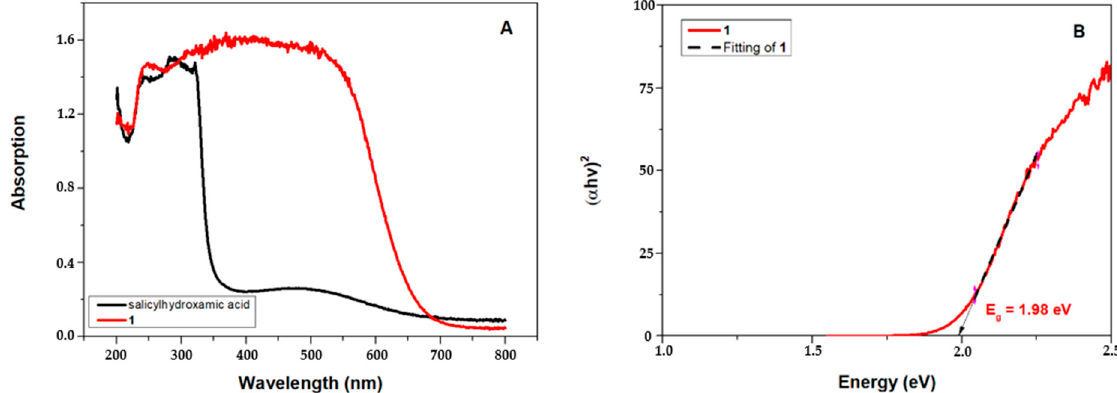
Figure 11. Solid-state UV − Vis spectra of the tetranuclear titanium(IV) compound 1 and the ligand H 2 dihybe ( A ). Tauc plot of compound 1 ( B ).